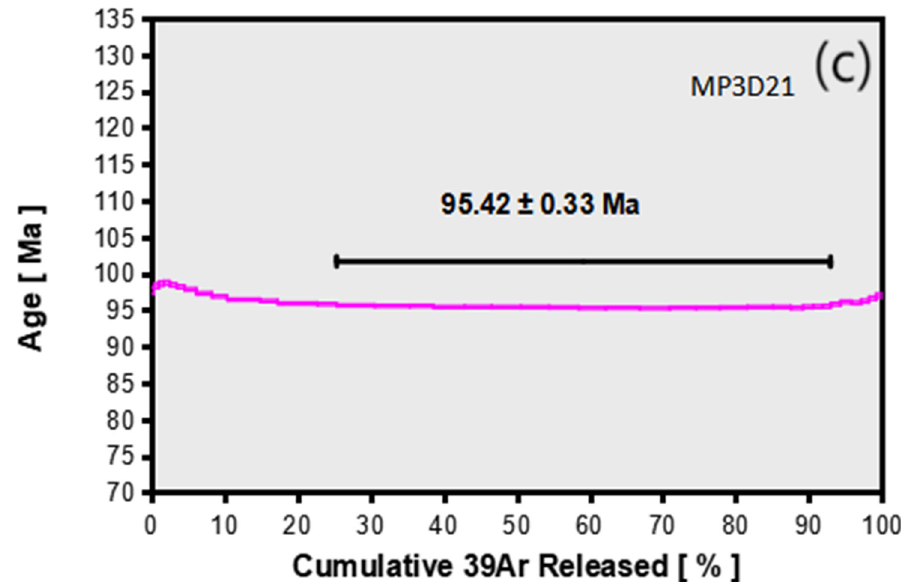
Figure 3. 40 Ar/ 39 Ar age analysis results for basalts from seamounts in the Western Pacific. ( a ) sample MP5D11; ( b ) sample MP5D15A; ( c ) sample MP3D21.